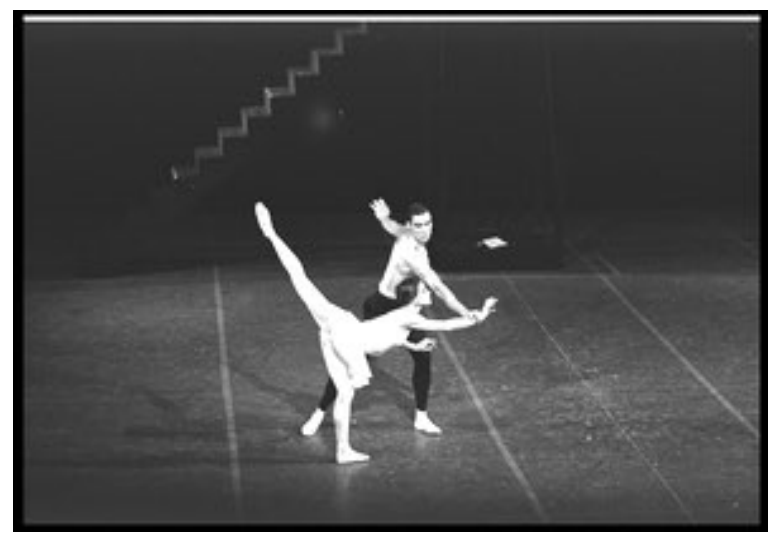
Figure 1. George Balanchine’s Apollo in 1964. NYCB dancers: Melissa Hayden and Jacques D’Amboise. Photo © Martha Swope and the New York Public Library, used with permission. Arts 2020 , 9 , x FOR PEER REVIEW